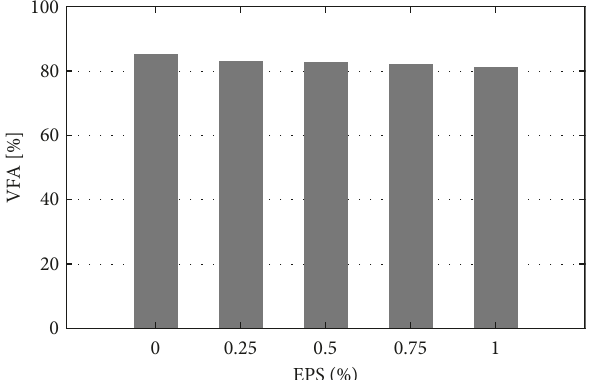
Figure 13: Relationship between air void and EPS.